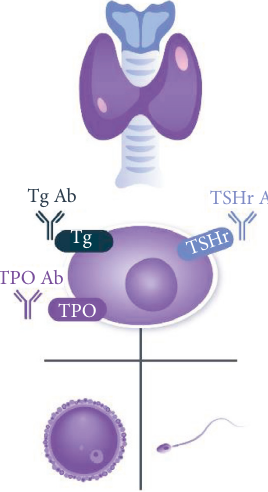
Figure 1: The negative effect of thyroid autoimmunity on female and male